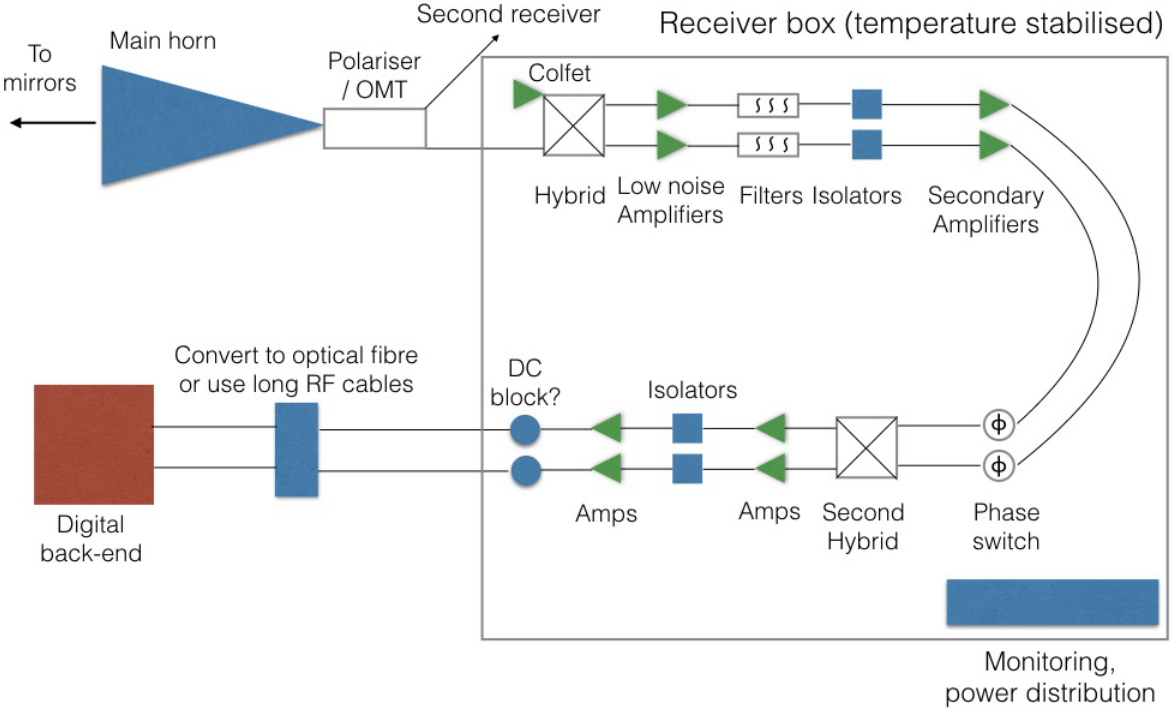
Figure 7. Block diagram of the main components of the BINGO correlation receiver. The correlation is achieved by means of the hybrids (in our case, “magic tees”) , which in our case will be waveguide magic